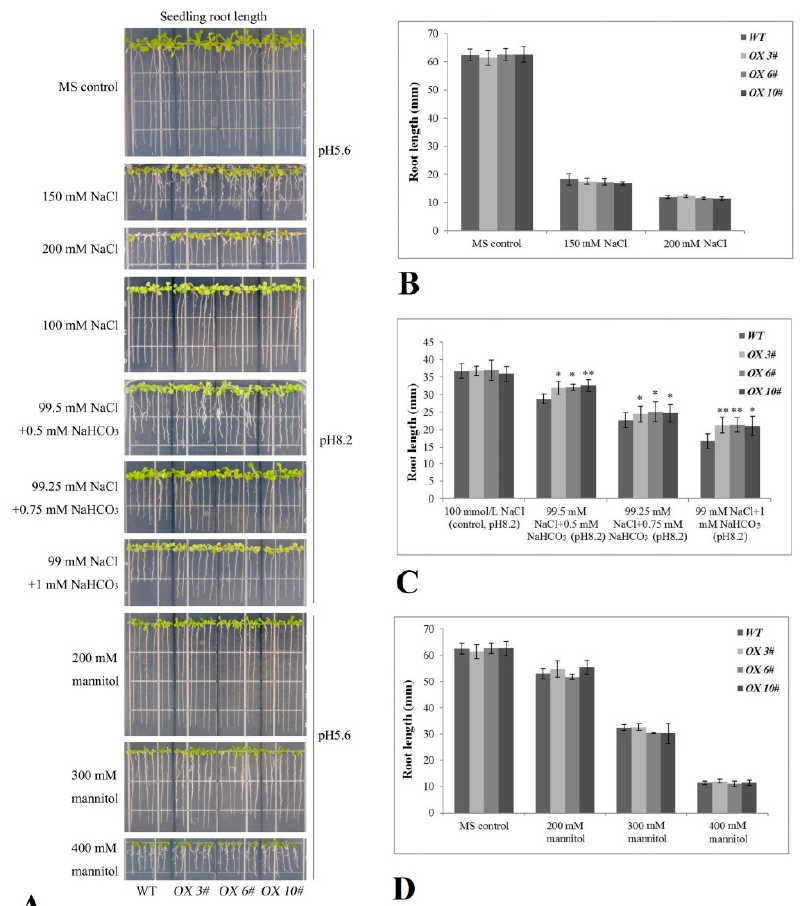
Figure 6. Salt, salt–alkali, and high osmotic stress analyses of transgenic plants with CrPIP2;3 based on seedling root length. Four-day-old seedlings were transplanted into MS medium containing NaCl, NaCl plus NaHCO 3 (pH 8.2) or mannitol and were then grown for 7 d before measuring the root length. ( A ) Photographs of transgenic lines ( CrPIP2;3 OX 3# , OX 6#, and OX 10# ) and WT seedlings on MS medium or MS medium with NaCl, NaCl plus NaHCO 3 (pH8.2), or mannitol; ( B – D ) seedling root length (mm) of WT and transgenic lines under NaCl ( B ), NaCl plus NaHCO 3 (pH 8.2) ( C ), or mannitol ( D ) stresses after 7 d. Error bars indicate the SD based on at least three replicates ( n ≥ 3). Asterisks indicate significant differences from the control (Student’ s t -test, * P < 0.05 and ** P < 0.01).